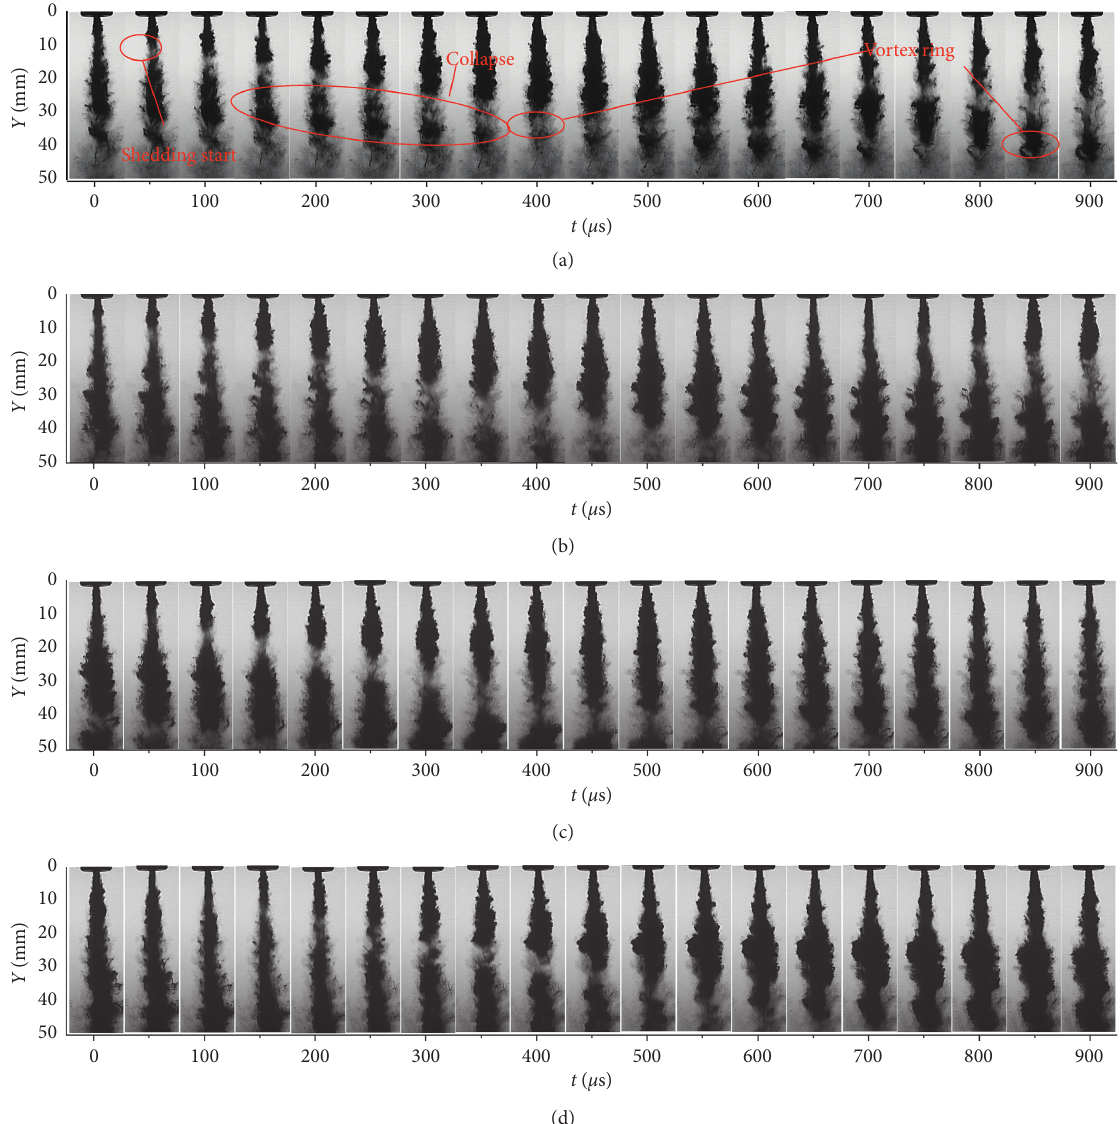
Figure 5: Cavitation cloud distribution of nozzle with divergent angle of 40 ° under different pressures. (a) σ � 0 . 0124, (b) σ � 0 . 0099, (c) σ � 0 . 0082, and (d) σ � 0 .